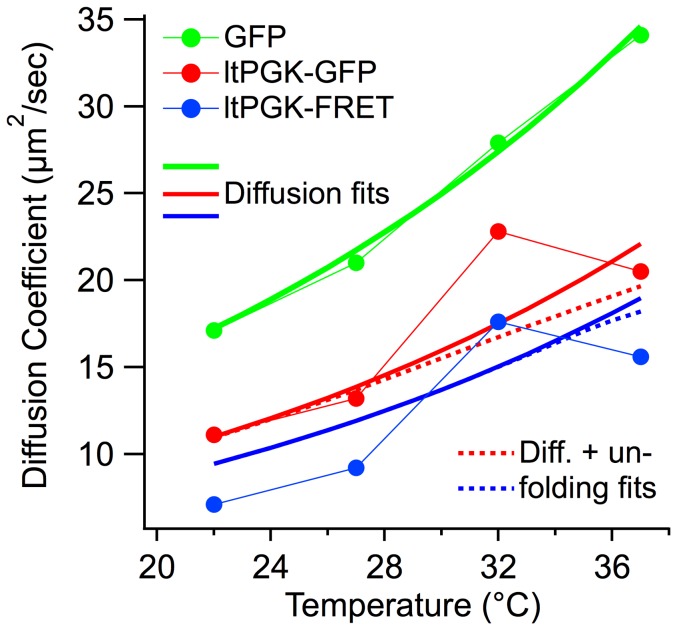
Comparison of the diffusion coefficients of the GFP, ltPGK-GFP and ltPGK-FRET measured from 22°C to 37°C.All proteins diffuse faster at higher temperatures while folded. The “lt” proteins show accelerated diffusion followed by a turnaround at T near T
m. Global model fits are to equation 1 (solid thick lines) and equation 2 (dotted thick lines).